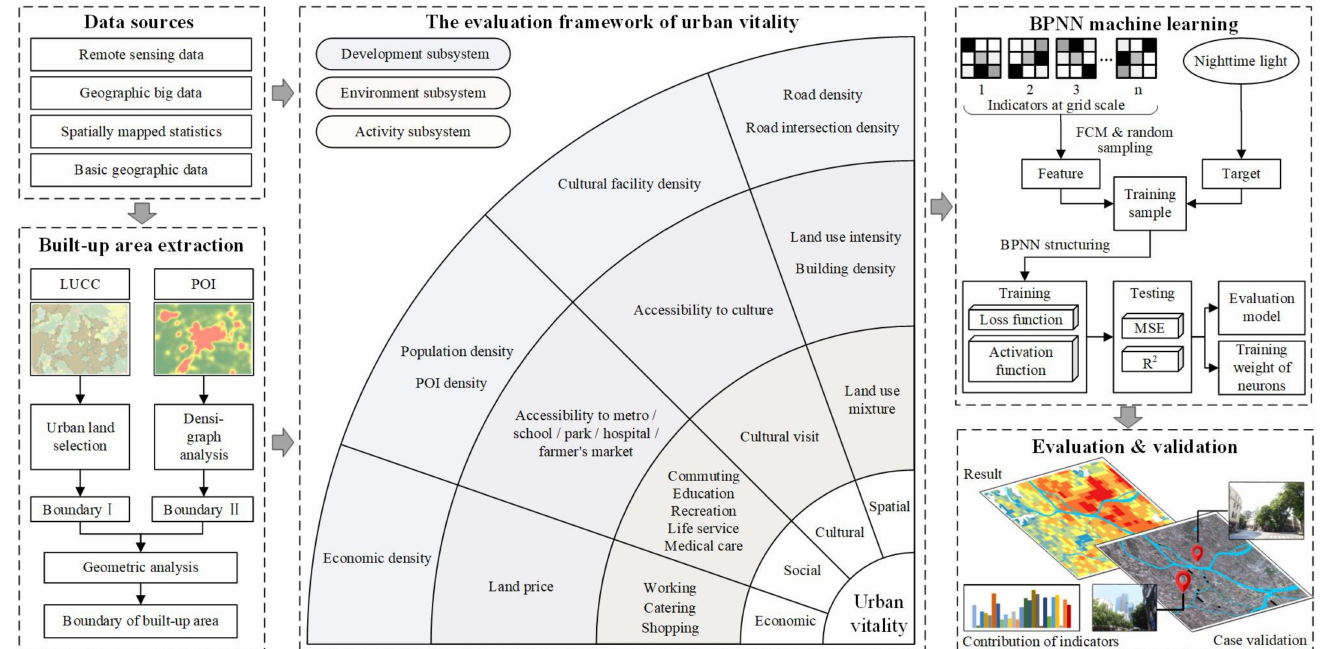
Figure 2. The research